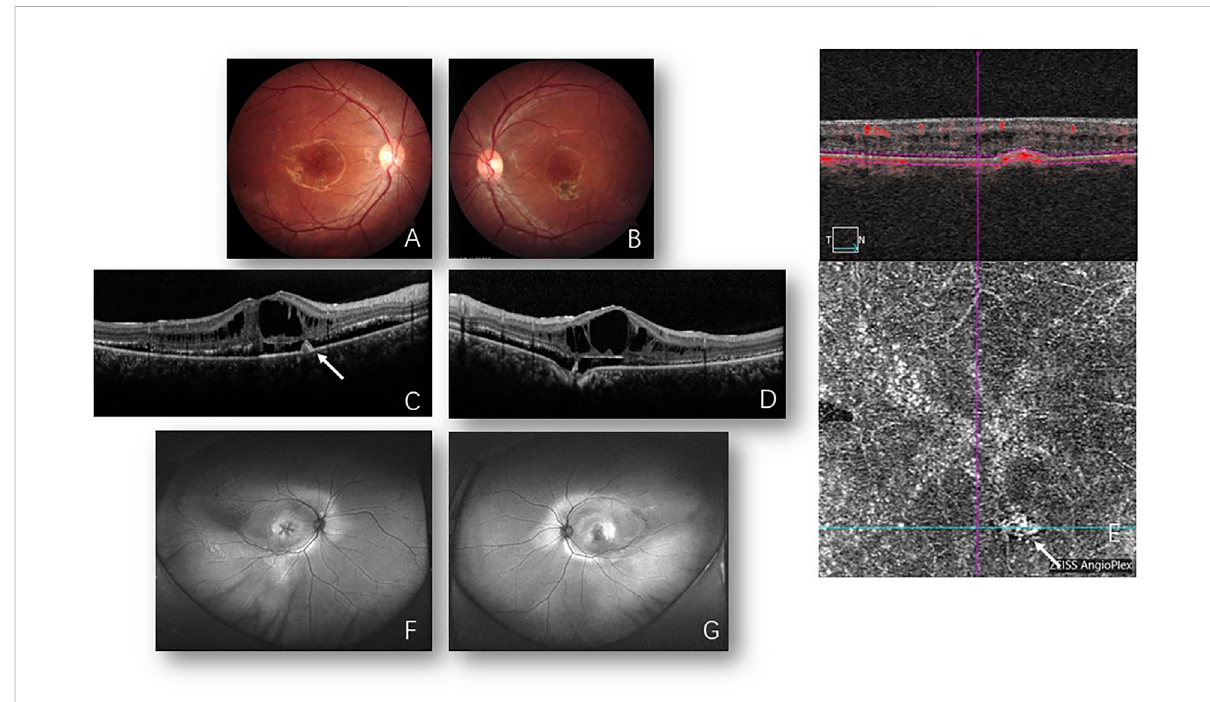
FIGURE 2 Images from 2021. Fundus photos of the right (A) and left (B) eyes reveal bilateral cystoid changes in the macula and bilateral pigmented lesion inferiortothemacula.Opticalcoherencetomography(OCT)oftheright (C) andleft (D) eyesshowsfovealretinoschisiswithenlargedcystspresently when compared to back then in 2008 (Figures 1C, D) and “ shaggy ” photoreceptors in the subretinal space. Focal choroidal excavation is detected in the left eye (D) . Hyperre fl ectivity lesion in the RPE layer (C) corresponding to inactive macular neovascularization (MNV) is detected and con fi rmed by OCTA (E) (white arrow). Fundus auto fl uorescence (F,G) shows bilateral cystic changes in the macula and symmetric annular area of hyper fl uorescence,suggestingretinalpigmentepithelium(RPE)aberrationintheposteriorpolewhichextendsnasaltothediscinbotheyesmingled with subretinal deposits are present. Laser spots are distributed in the temporal peripheral retina in the right